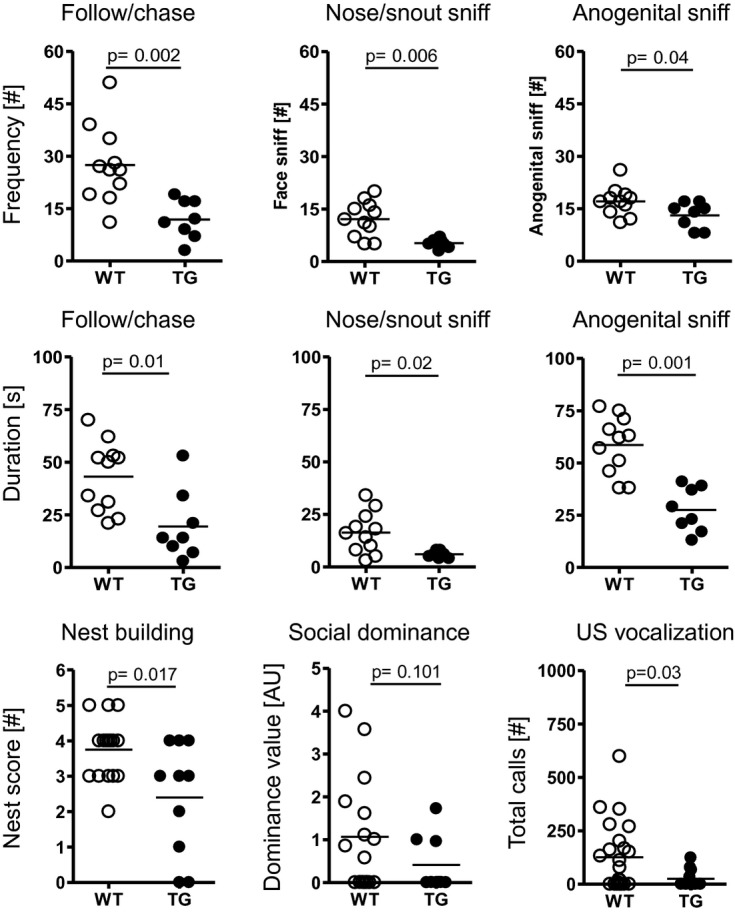
Male TG C57BL/6N mice show reduced territorial social interaction as well as inferior social competence.Upper 2 rows: Frequency and duration of determinants of territorial social interaction, that is, follow/chase behavior, nose/snout sniff and anogenital sniff, are consistently reduced in TG carriers. Lower row: TG mice are inferior in nest building, social dominance behavior and ultrasound vocalization. N = 10–23; mean ± s.e.m. given.